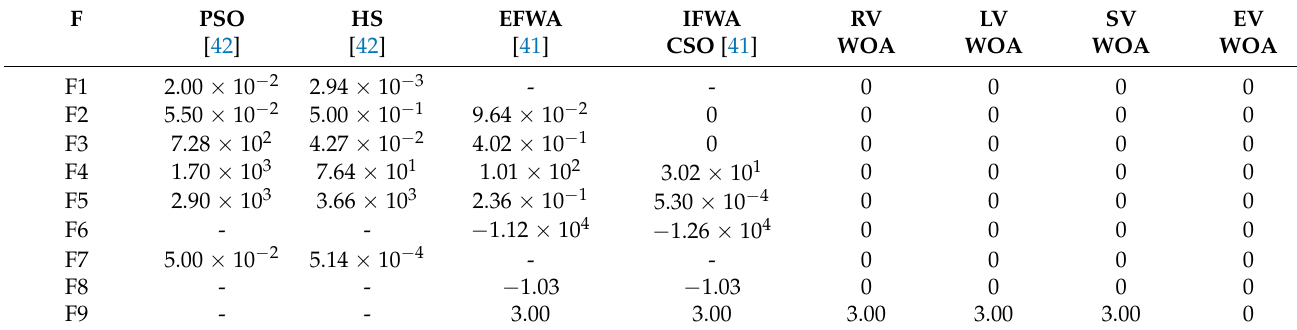
Table 2. Comparison of the Results of Benchmark